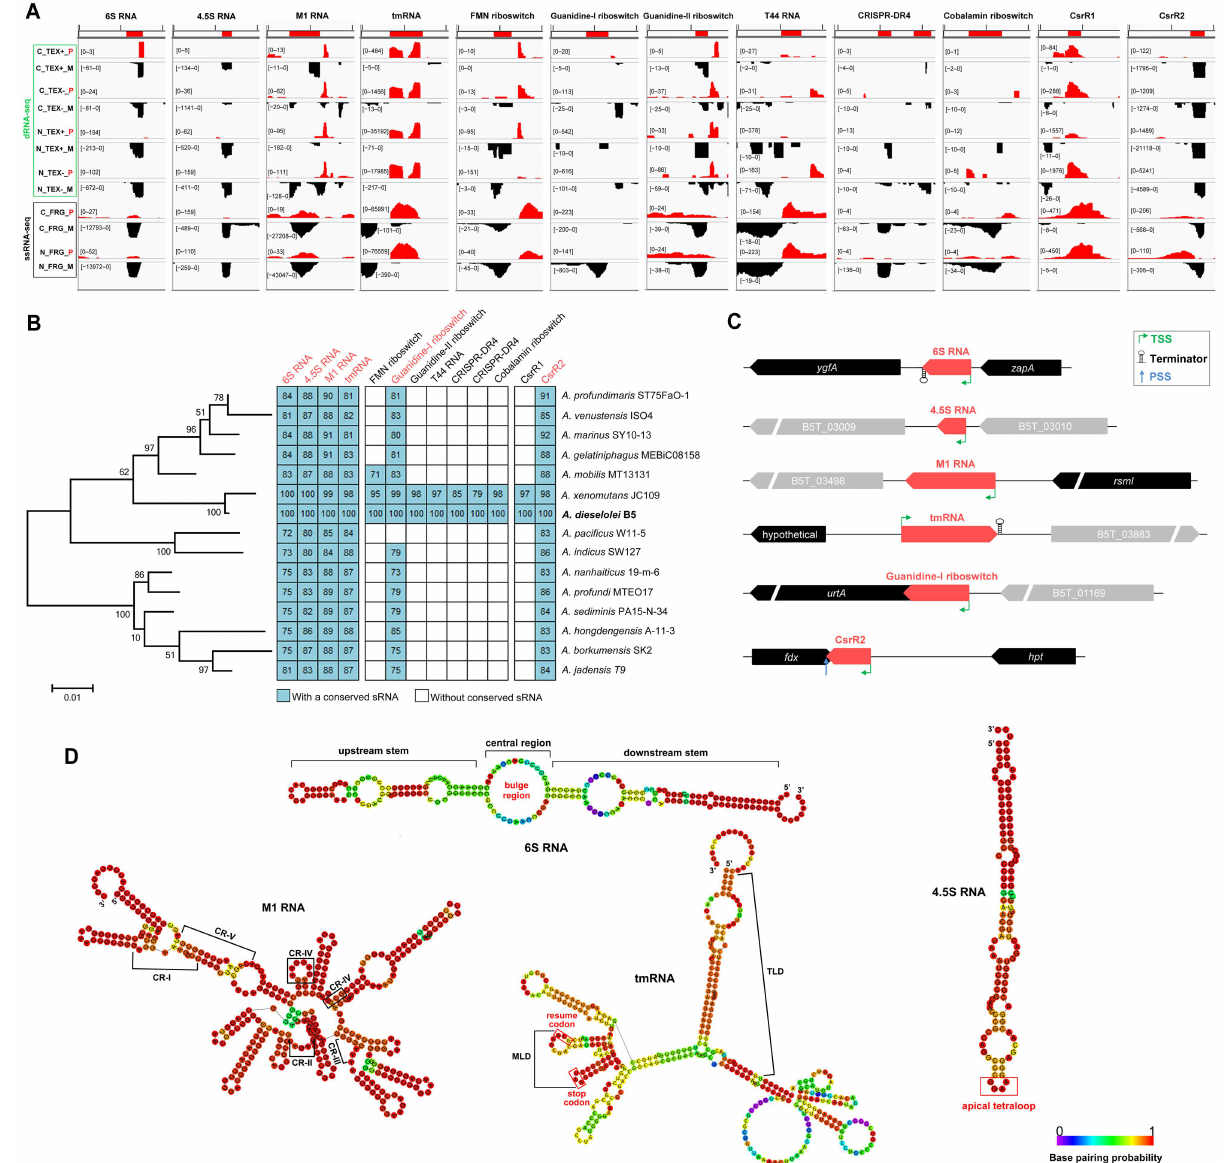
Figure 4. Rfam-annotated sRNAs of A. dieselolei and their distributions in genus Alcanivorax . ( A ) IGV views on the read coverages of Rfam-annotated sRNAs. Tracks display the different experimental conditions (i.e., C for C16 (hexadecane) and N for NaAc (sodium acetate) carbon sources) and RNA- seq strategies (i.e., TEX+ and TEX- for dRNA-seq and FRG for ssRNA-seq). The reads mapped on the plus (P) and minus (M) strands of the genome are in red and black colours, respectively. ( B ) The homologs of Rfam-annotated sRNAs in Alcanivorax. The left part shows the 16S rRNA gene-based maximum-likelihood phylogenic tree of representative Alcanivorax species constructed using MEGA6 (www.megasoftware.net, accessed on 19 May 2022), the bootstrap values that are more than 50 are presented on the related branches. The middle part shows the distributions and identities (%) of sRNAs in different species, and the names of broadly conserved sRNAs are in red. The right part shows the names of corresponding species. ( C ) Neighboring gene synteny of highly conserved sRNAs. The red arrows in the middle represent the sRNAs, black for the highly conserved nearby genes and grey for the less conserved genes. The arrow direction to the left indicates genes on the minus-strand and to the right for the plus-strand. The details of the nearby genes are listed in Table S12. ( D ) Secondary structures and conserved features of the core